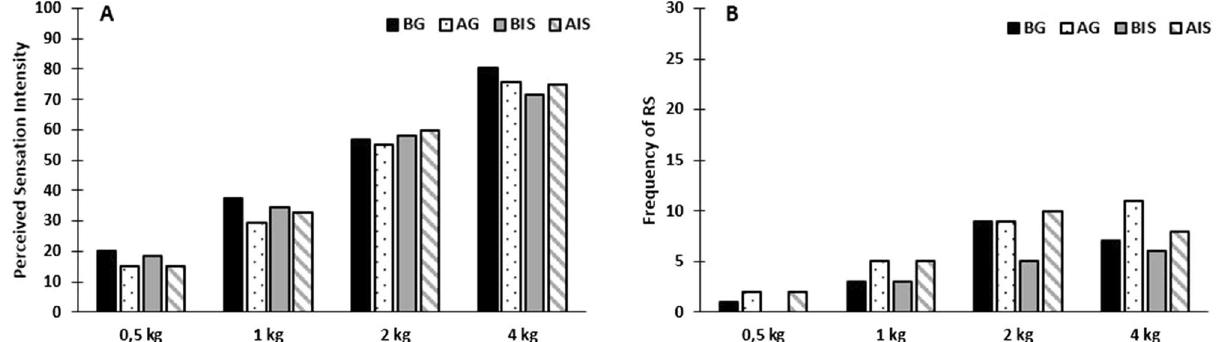
Figure 2. Referred sensations and perceived sensation intensity following mechanical stimulation of the masseter muscle. No significant difference was found between before and after injections regarding perceived sensation intensity ( A ) and referred sensations ( B ) following palpation of the masseter muscle. BG—Before glutamate; AG—After glutamate; BIS—Before isotonic saline; AIS—After isotonic